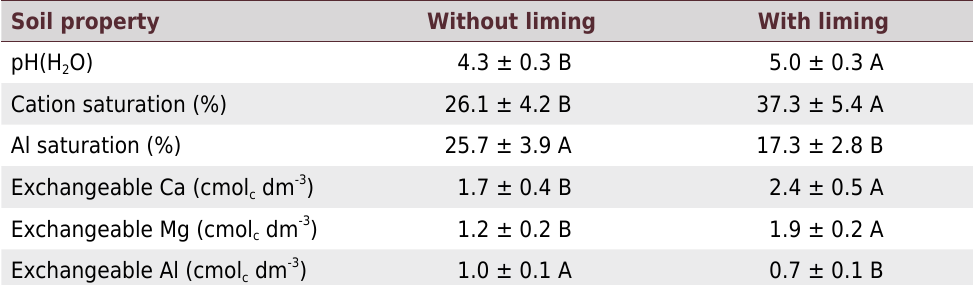
Table 3. Acidity-related chemical properties of the soil in the 0.00-0.20 m layer 18 months after surface liming in the ICLS Soil property